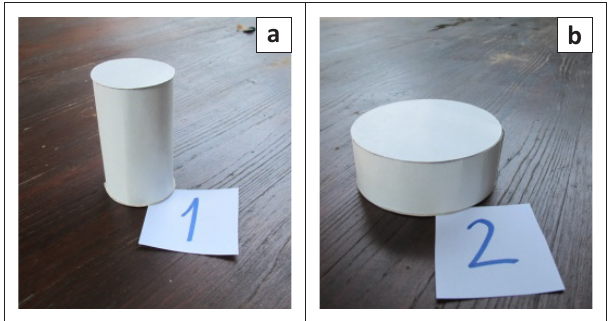
FIGURE 2: A prototype cylinder (a) and a non-prototype cylinder (b). a